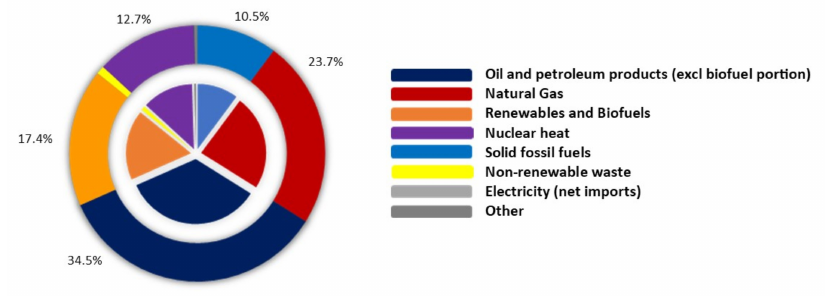
Figure 3. The EU energy mix in 2020 (authors’ elaboration on